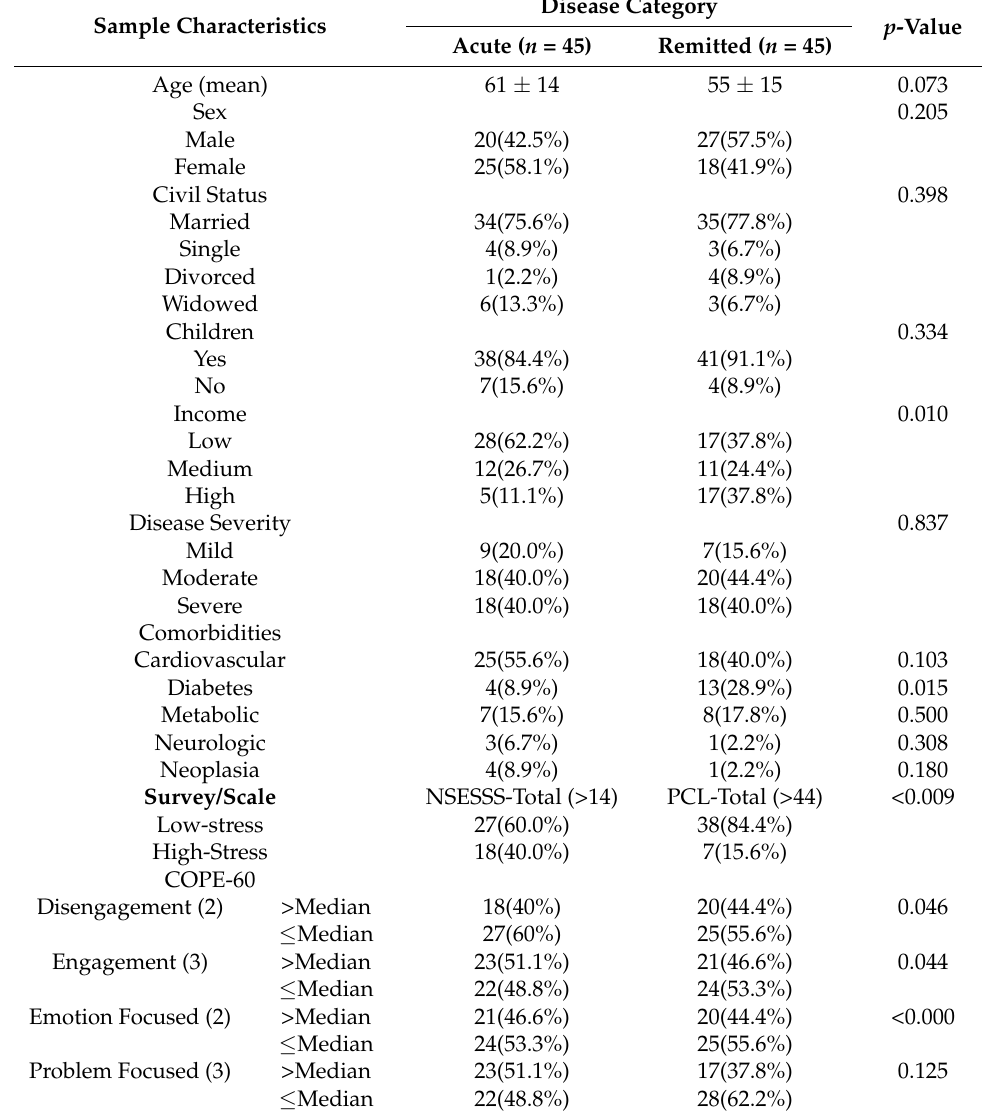
Table 1. General characteristics of the study groups. Data in this table was divided by disease category to compare the variables describing general characteristics and survey